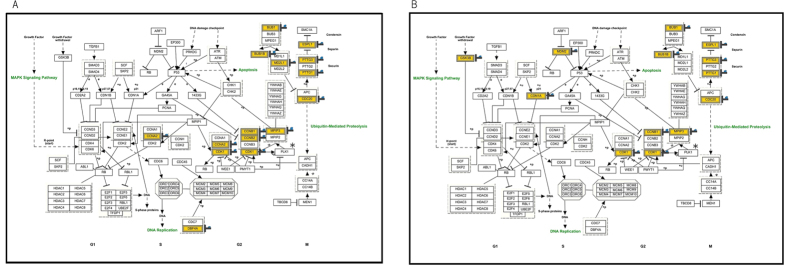
Mitotic genes are predominantly induced for the cell cycle-related genes at 12 h following UV exposure.The significantly upregulated genes within Cell Cycle (WP179_70629) are depicted in the case of LUV (A) and HUV (B). The brown columns show the significantly upregulated genes (≥2-fold difference). *PLK1 was filtered out by insufficient flag value in the un-irradiated sample for significantly upregulated genes despite the significant upregulation of PLK1 in both HUV and LUV at 12 h in the Supplementary Fig. S2.